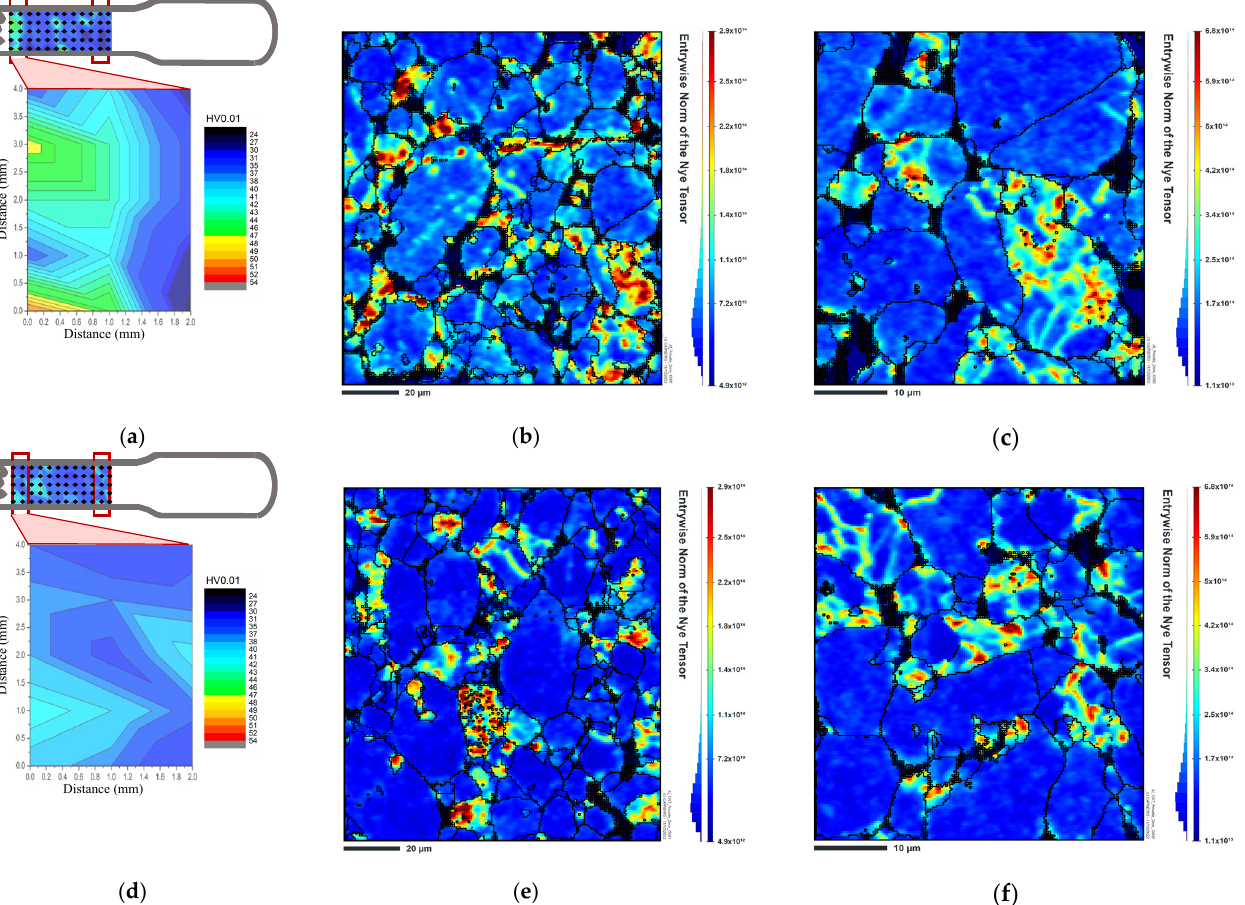
Figure 11 . Hardness distribution maps (HV 0.01) of ( a ) Al and ( d ) Al/CNT of fractured tensile test specimens close to the fracture and average geometrically necessary dislocations (GNDs) density maps of ( b , c ) Al and ( e , f ) Al/CNT samples.